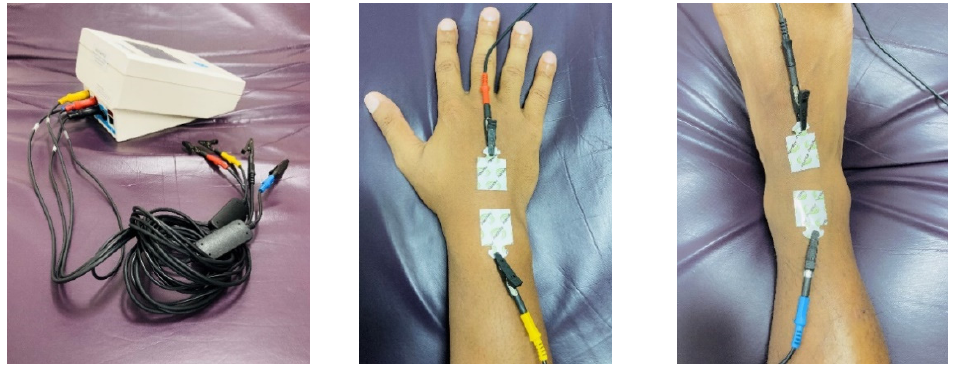
Figure 2. Laboratory-based bioimpedance device; photo courtesy of Clifton J. Holmes, PhD.